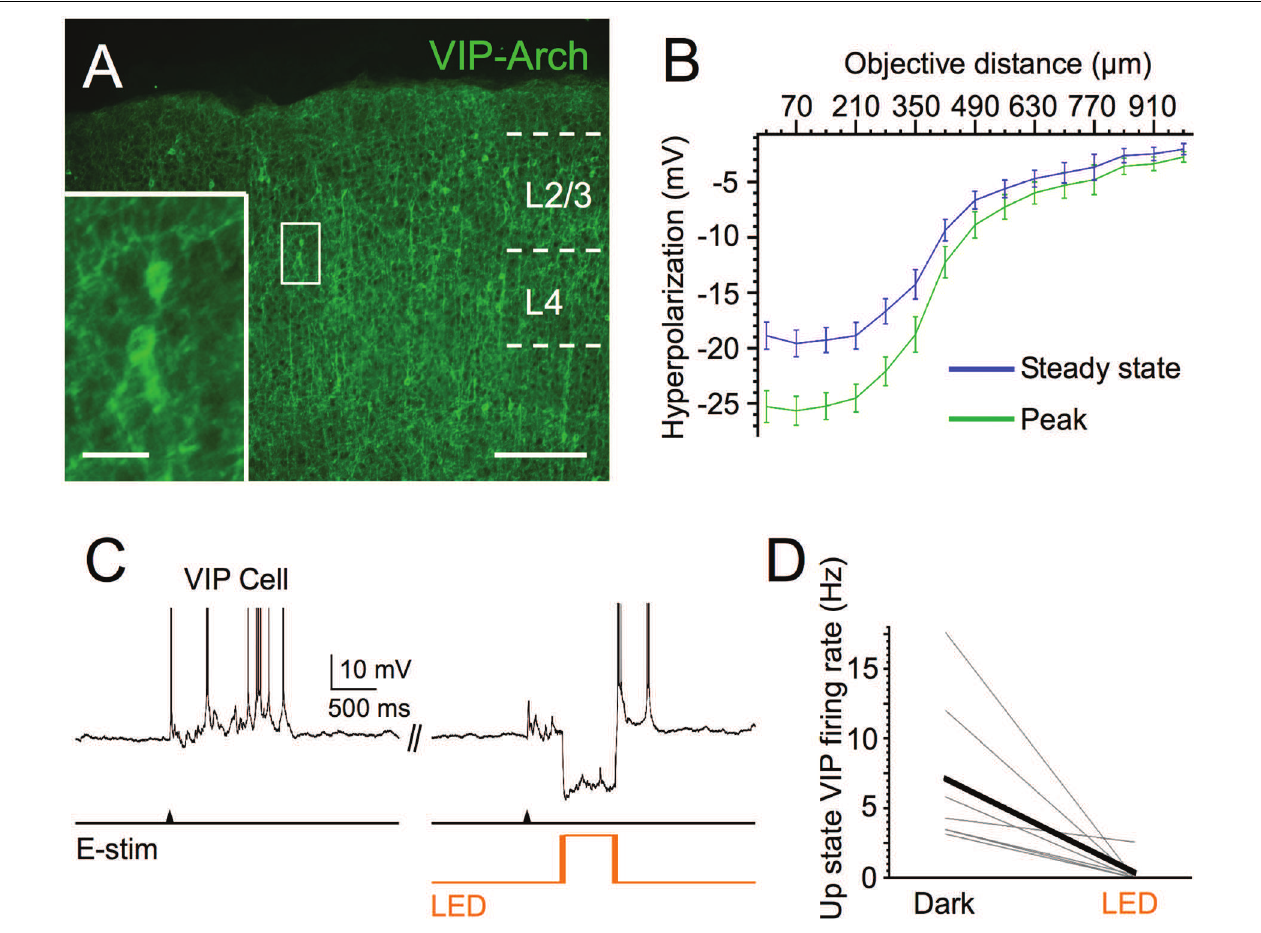
FIGURE 4 | Efficacy of Arch expression in VIP cells. (A) Fluorescent image of Arch-EYFP-expressing VIP cells in superficial layers of barrel cortex; scale bar = 200 µ m. Inset: expanded view of 2 Arch-expressing VIP cells, scale bar = 20 µ m. (B) Light-evoked hyperpolarization (500 ms pulse duration) of Arch-expressing VIP cells in layer 2/3 as 40x immersion objective is moved away from the recorded cell in 70- µ m increments ( n = 6 cells). Peak and steady-state values are measured as in Figures 1B,C . (C) Voltage trace of example VIP cell during photostimulation. (D) Light stimuli significantly decrease spiking output of layer 2/3 Arch-expressing VIP cells during evoked Up states ( n = 7 cells; Dark: 7.1 ± 2.1 Hz, LED: 0.4 ± 0.4 Hz, P = 0.022, paired t